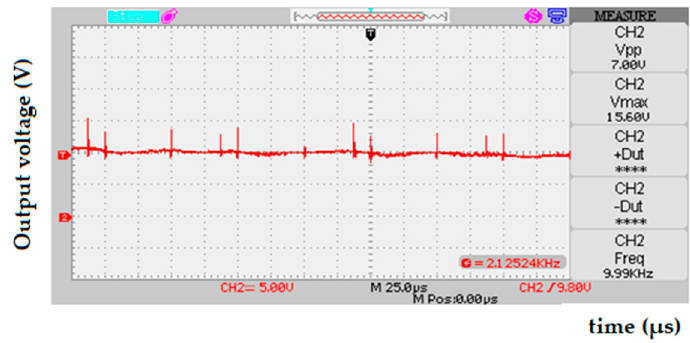
Figure 18. Output voltage waveform MPIBC (six phase). **** Duty Cycle = 0.5. The output current, output voltage, and output power of MPIBC (six phase) at